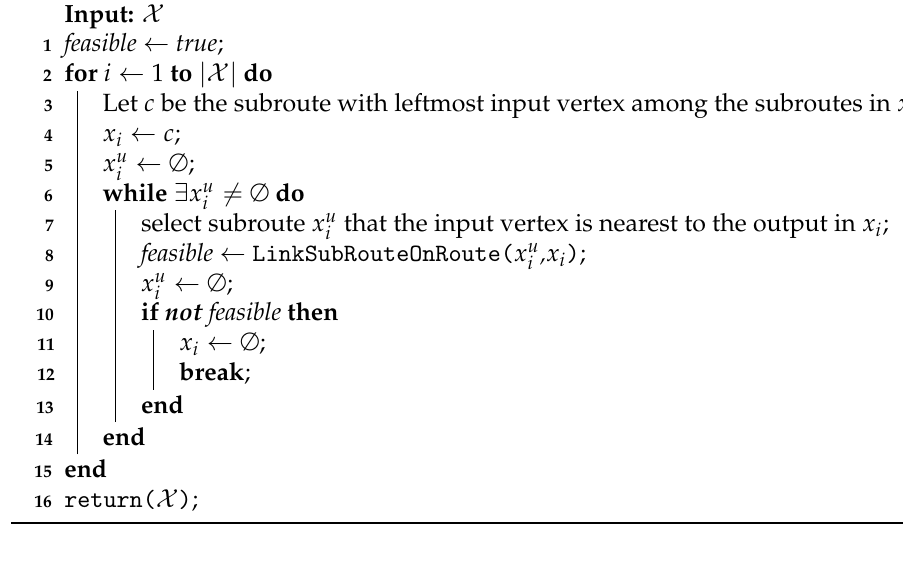
Algorithm 4: Linking subroutes to build a start solution.